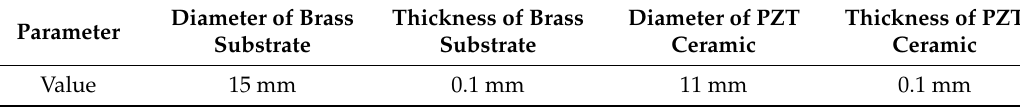
Table 1. The parameters of the PZT